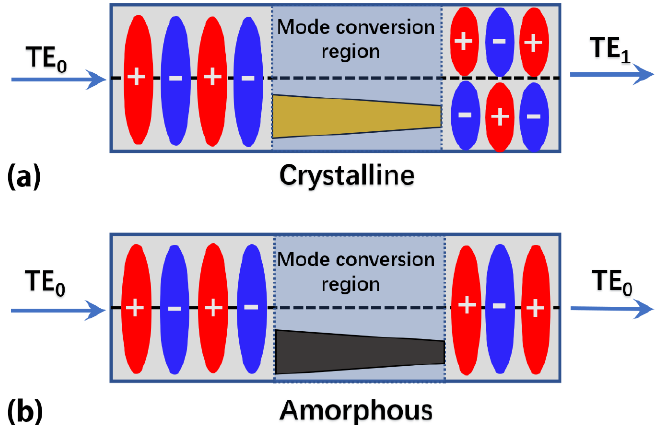
Figure 2. Schematic of mode conversion in the two phase states of the Sb 2 Se 3 layer. ( a ) Mode conversion from input TE 0 mode to output TE 1 mode when the Sb 2 Se 3 layer is in the crystalline state. ( b ) No mode conversion when the Sb 2 Se 3 layer is in the amorphous state. Yellow (gray) color of Sb 2 Se 3 layer represents the crystalline (amorphous) state. The symbols “+” and “−” represent the positive and negative phase of the electric field mode.